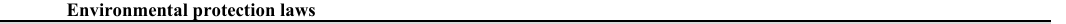
Environmental protection laws